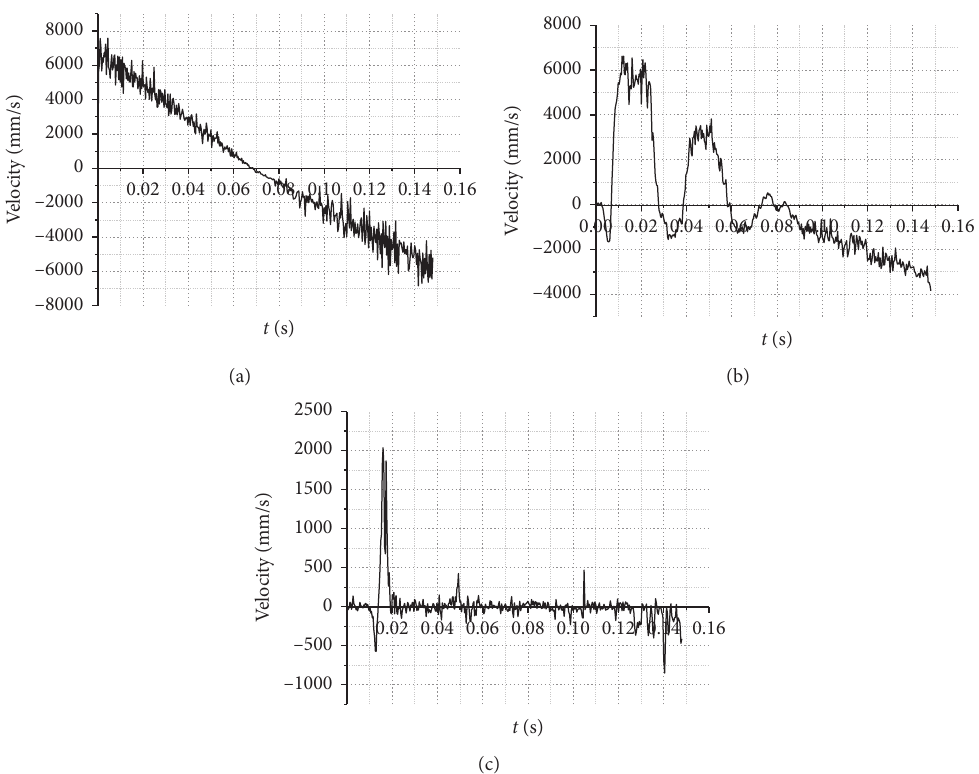
Figure 13: Speed-time curves of different coils. (a) The 1st coil. (b) The 18th coil. (c) The 35th coil.